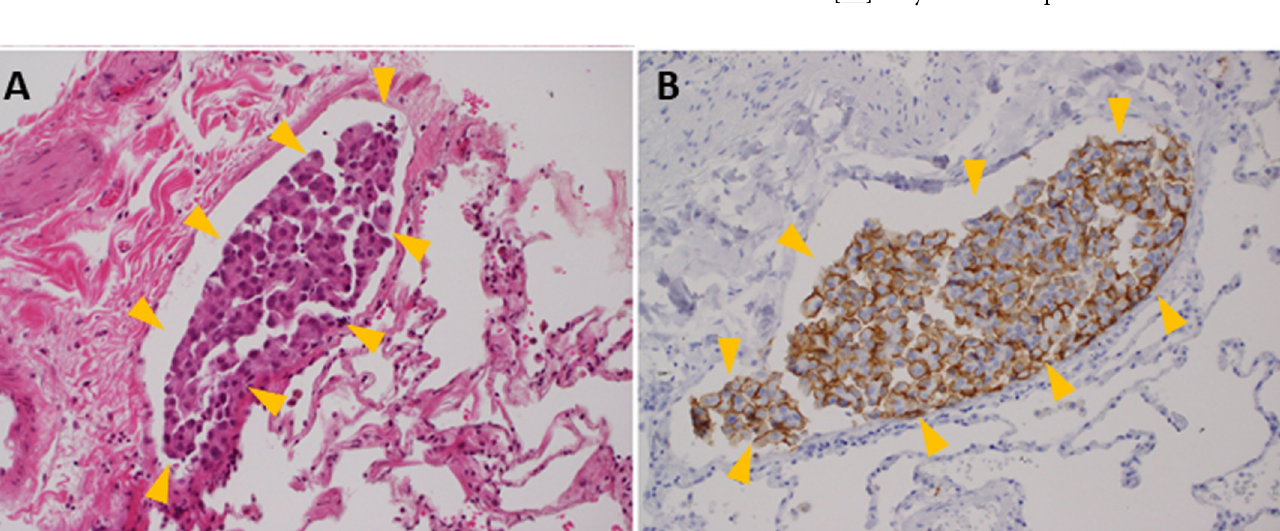
PLOS ONE | https://doi.org/10.1371/journal.pone.0215237 April 11,